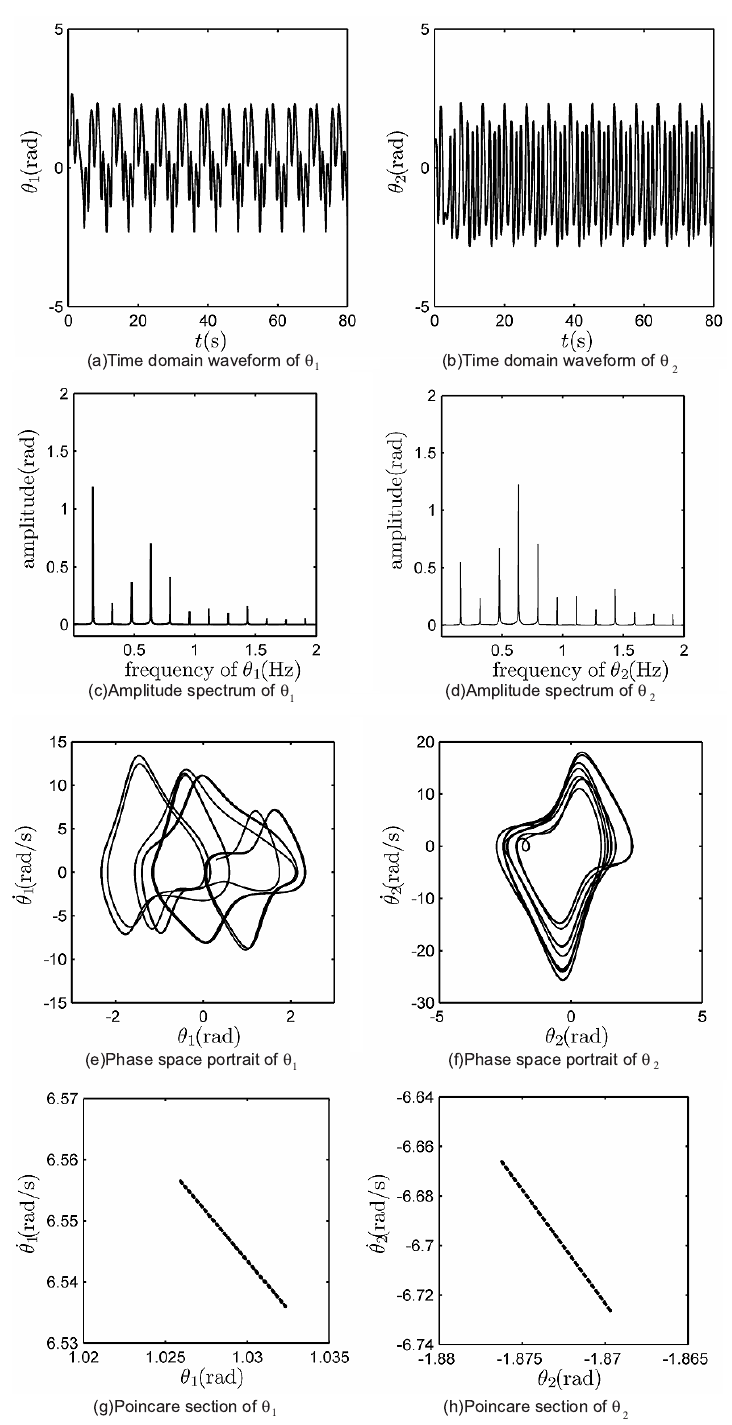
Fig. 5. The simulated quasi-periodic motions [(a) Time domain waveform of θ 1 , (b) Time domain waveform of θ 2 , (c) Amplitude spectrum of θ 1 , (d) Amplitude spectrum of θ 2 , (e) Phase space portrait of θ 1 , (f) Phase space portrait of θ 2 , (g) Poincare section of θ 1 , (h) Poincare section of θ 2